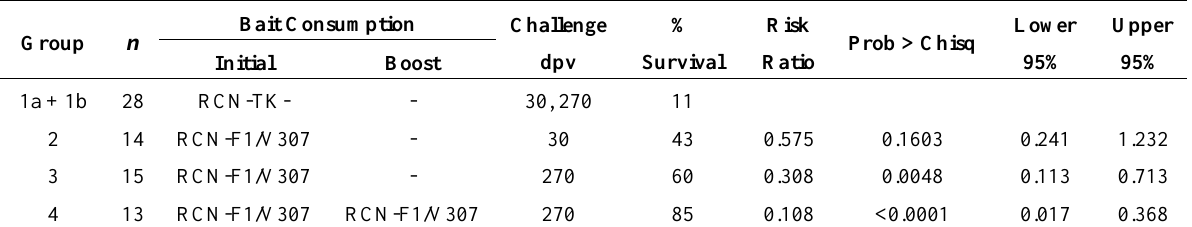
Table 5. Survival of prairie dogs that voluntarily consumed baits containing RCN-F1/307 (with and without a boost) or RCN-TK- (placebo) and were challenged with Yersinia pestis at 30 and 270 days post initial vaccination (dpv). Risk ratios are calculated in relation to the group consuming placebo baits (RCN-TK-). Lower and upper 95% indicate 95% confidence intervals on the risk ratio.